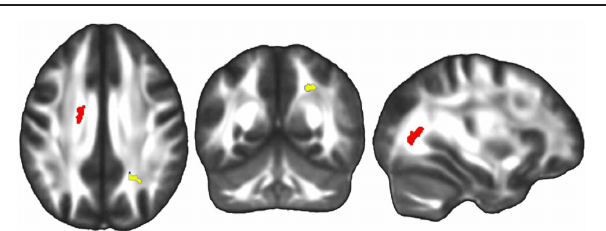
FIGURE 9 | Linear regression analyses revealed a significant positive correlation between change in the cognitive component of the Trails B score between time one and time three and FA change in the left superior SLF and right optic radiation over the same four year study duration (red). Analyses of sub-intervals revealed there was also a significant positive correlation between change in the Trails B cognitive component between the first and second time points, and FA change in the right posterior SLF over the same one year first interval duration (yellow). The left side of the statistical map is patient left and right is patient